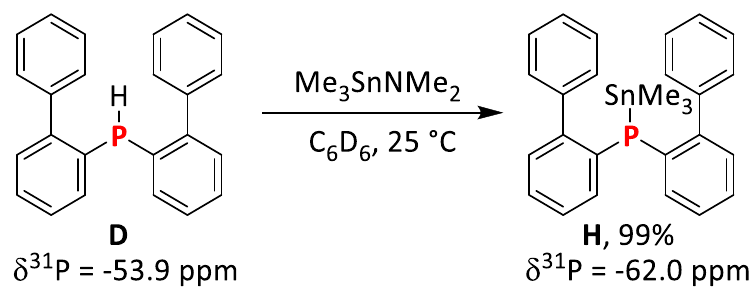
Scheme 9. Stannylation of phosphine D with (dimethylamino)trimethyltin.